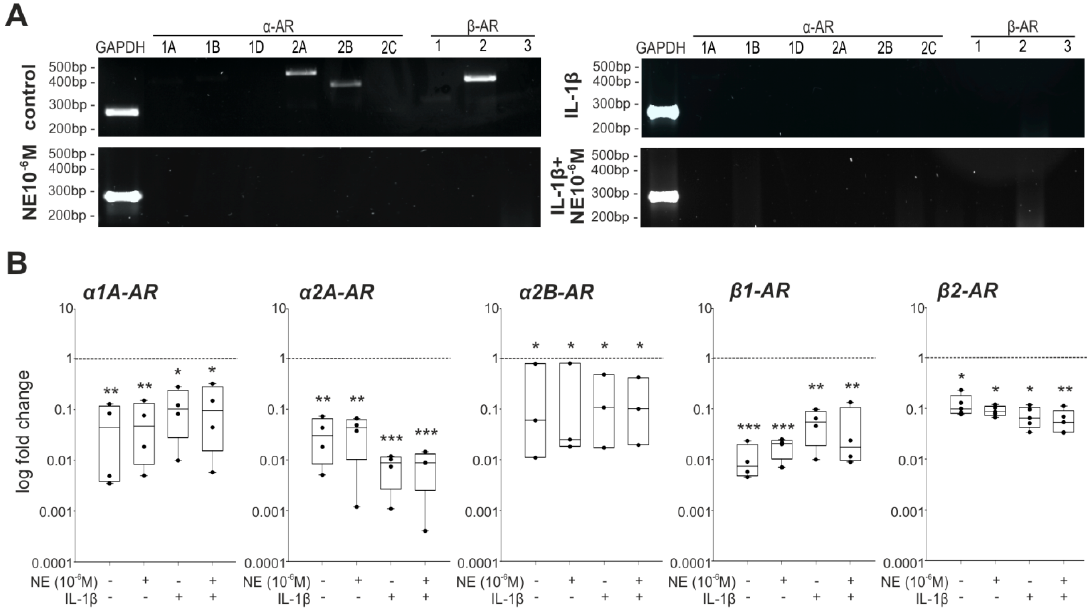
Figure 7. Adrenergic receptor profile of OA chondrocytes after seven days in monolayer culture. ( A ) Gene expression of different adrenoceptor subtypes in untreated or NE- and/or IL-1 β -treated primary chondrocytes at day 7 (representative images of cells isolated form one OA patient). ( B ) Quantitative PCR analysis of expression levels of adrenoceptor subtypes at day 0 and after seven days without treatment as well as under NE or/and IL-1 β influence and physioxic conditions. Significant p -values against day 0 are presented as: * ( p ≤ 0.05), ** ( p ≤ 0.01), *** ( p ≤ 0.001).